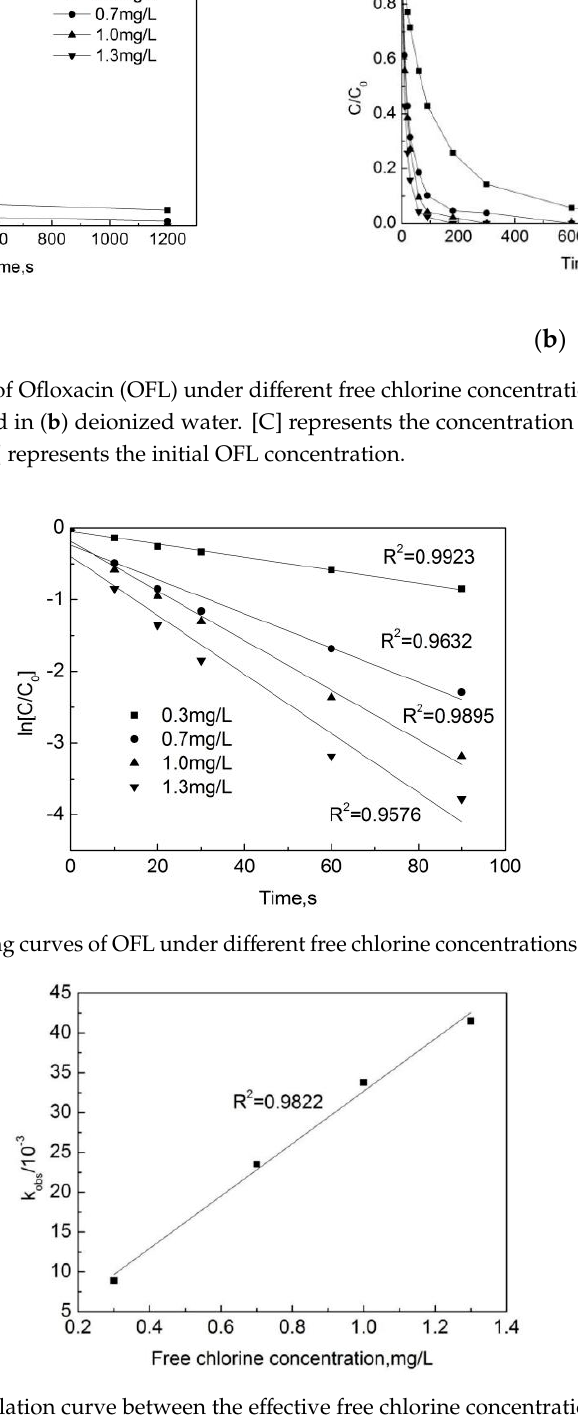
Figure 4. The relation curve between the effective free chlorine concentration and k obs .